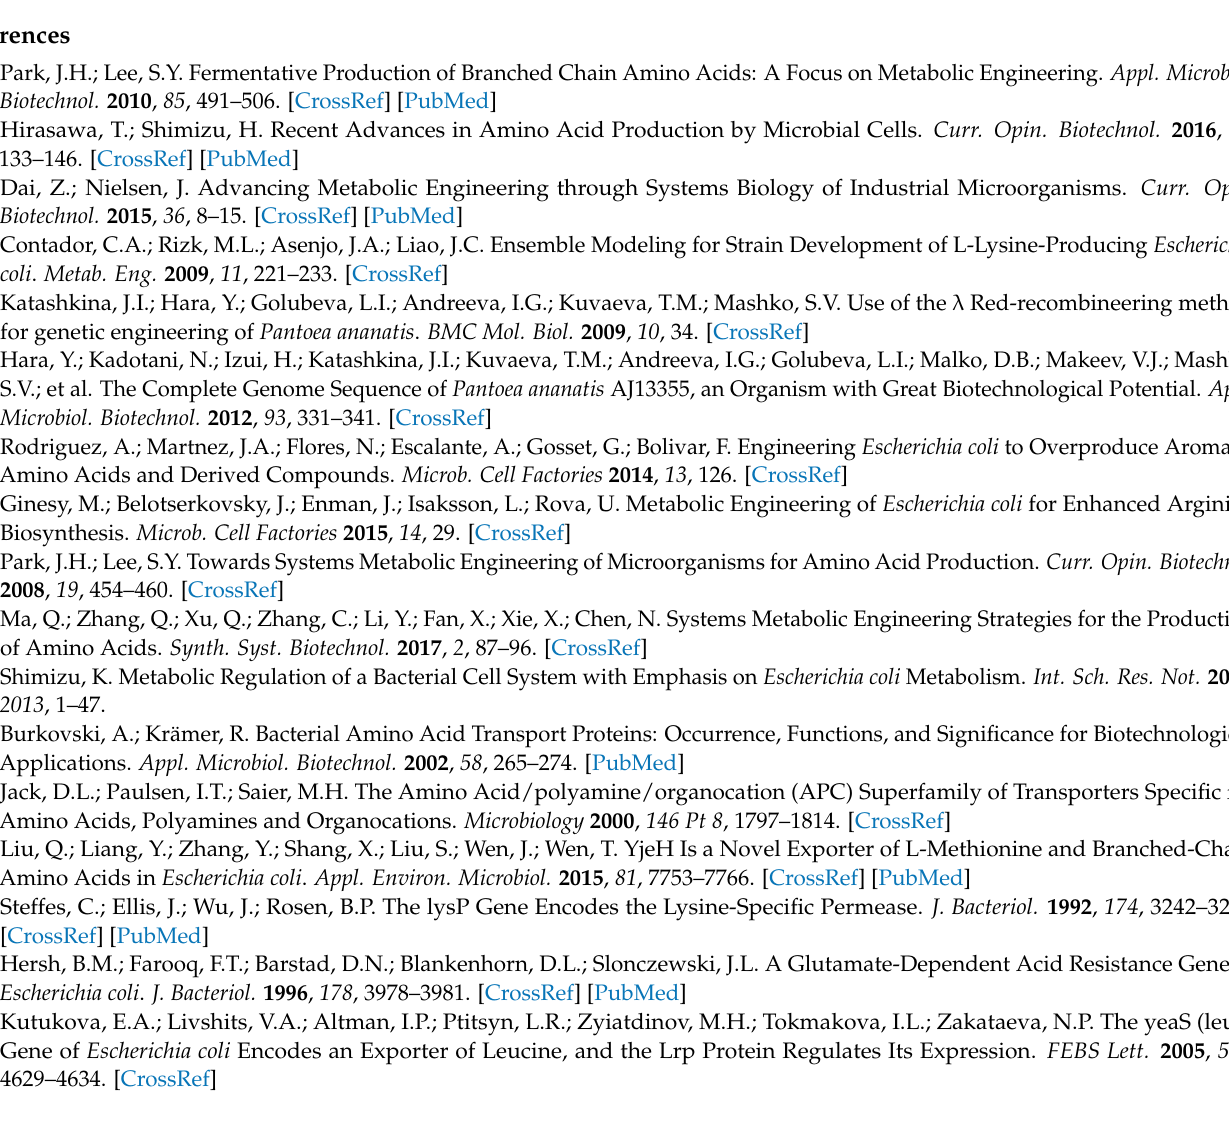
Table S1: Sequences of the PCR primers used in this